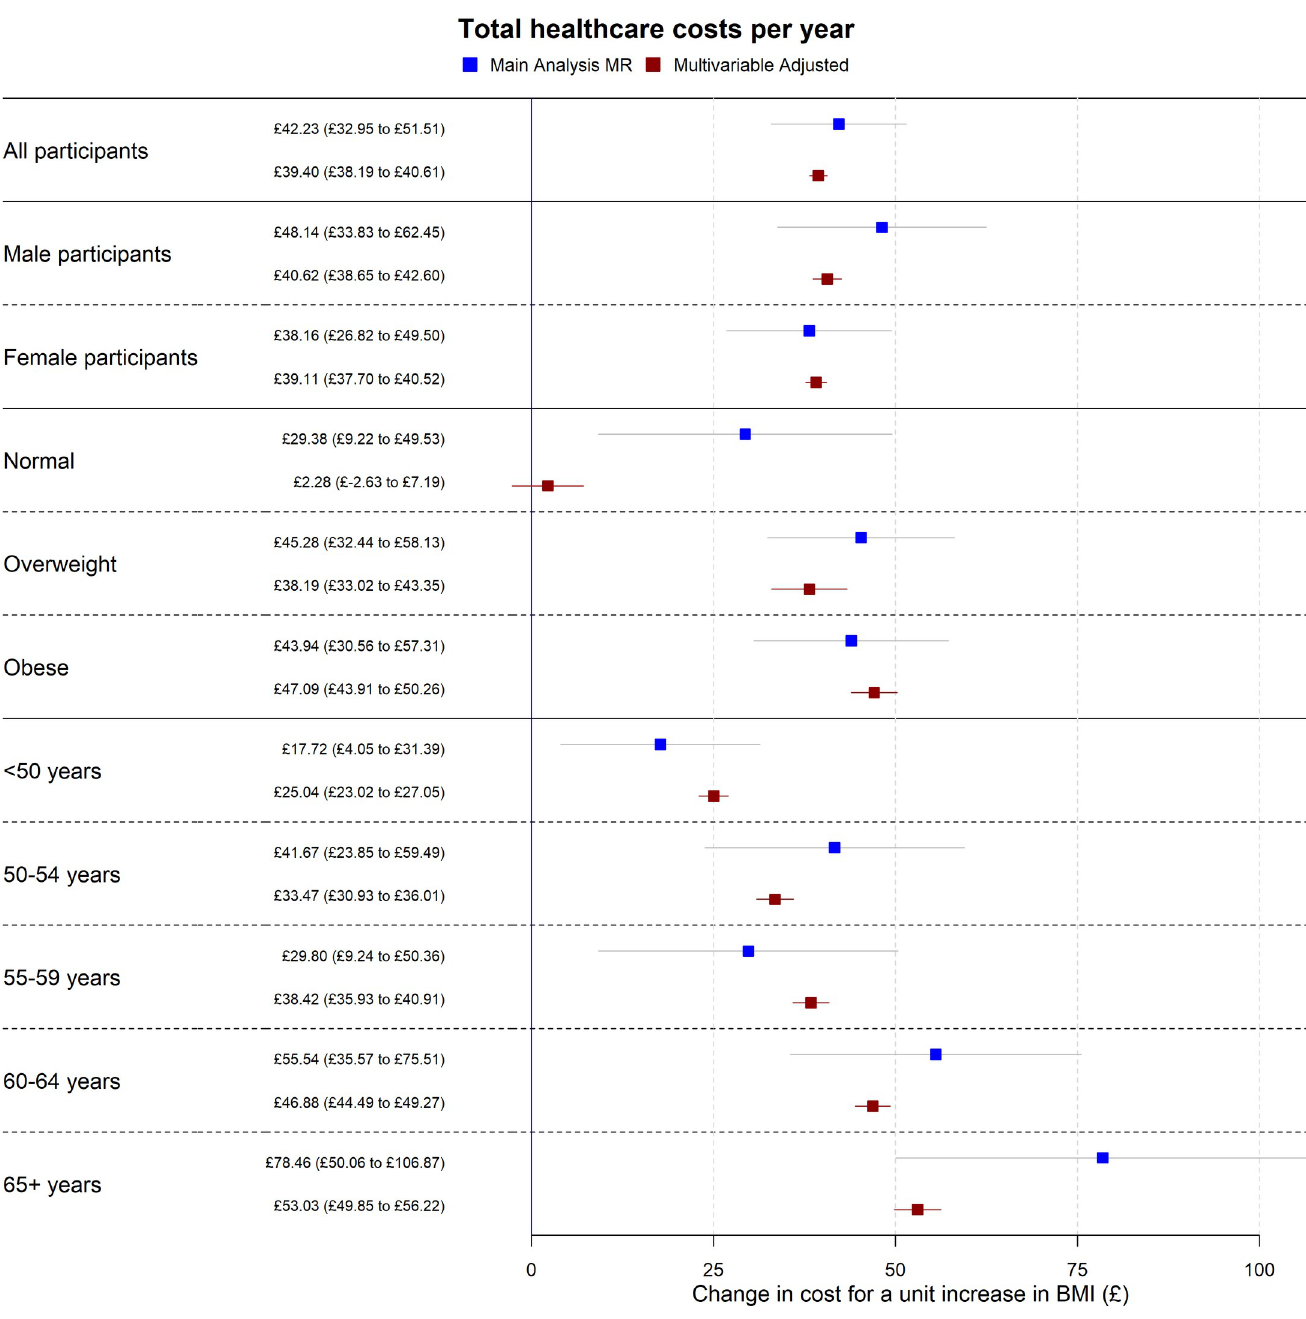
Fig 3. MR estimates for total healthcare costs per year. Forest plot showing the estimated effect of a unit increase in BMI on average total healthcare costs per year for the main MR, sex-specific, BMI categorical (where “Normal” is a BMI below 25 kg/m 2 , “Overweight” is a BMI between 25 kg/m 2 and 30 kg/m 2 , and “Obese” is a BMI of above 30 kg/m 2 ) and age categorical analyses. Effect estimates are indicated by squares, 95% CIs by horizontal lines around the squares. Effect estimates are derived from the main imputation model (for all and sex-specific estimates) or the categorical imputation model (for BMI and age category–specific estimates). Both analyses adjusted for age, sex, recruitment centre, and 40 genetic principal components. BMI, body mass index; CI, confidence interval; MR, mendelian randomisation.